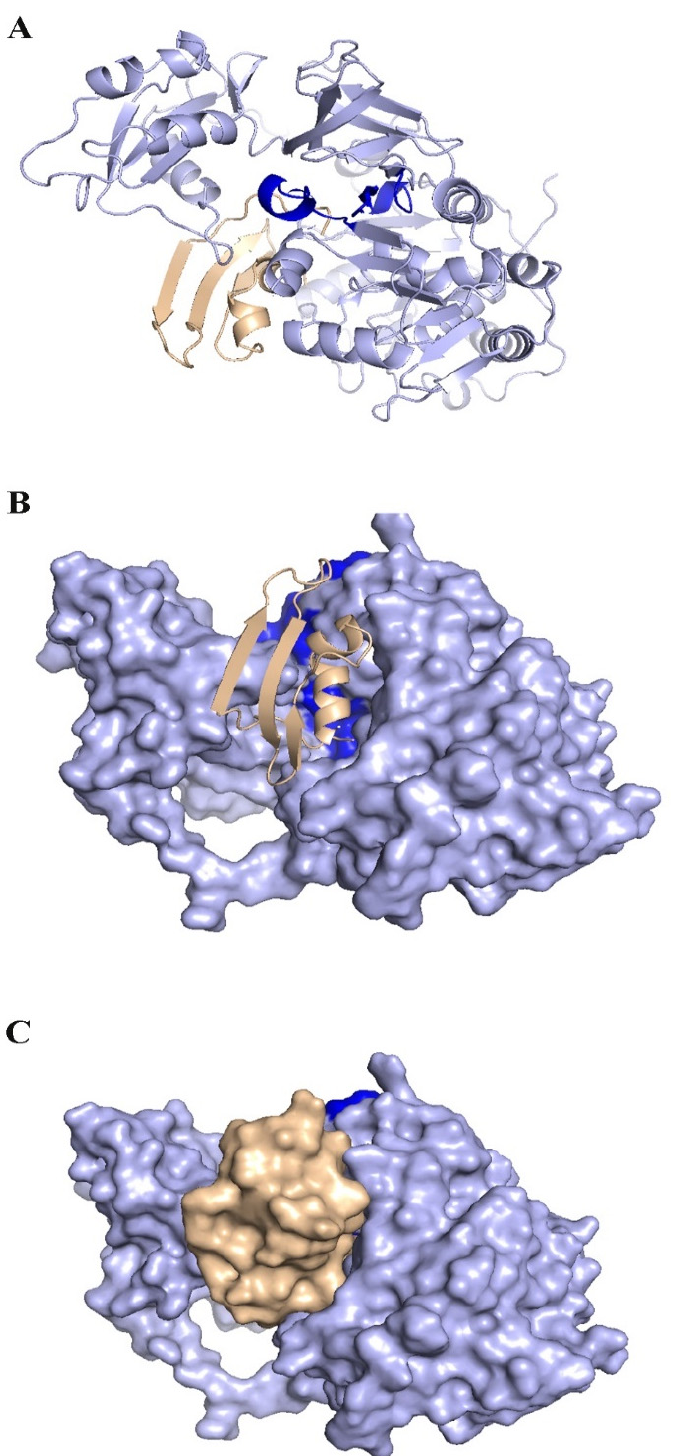
Figure 12. KAE01 EntP complexed with matrix protein. KAE01 EntP model (wheat color) with AB method complexed with matrix protein (light-blue color). Highly conserved residues Gly307, Gly302, Ala278, Gly279, His308, and Tyr211 in N-terminal domain are highlighted in dark blue. ( A ) Shows Ribbon representations ( B ) KAE01 Cavity occupied surface of protein ( C ) Both are represented in surfaces The KAE01 EntA bacteriocin binds to the matrix protein of P. aeruginosa in three clus- ters with 46 members from 1000 bootstraps in the best binding mode with a binding en- ergy of − 12.4 Kcal/mol and an inhibition constant of 0.8 nM (Table 5). KAE01 EntA local- izes near the conserved region of the N-terminal domain of the matrix protein of P. aeru- ginosa (G166, S167, and T169 loop in the N-terminal domain and F208 F209, G210, G279, and Ser280 residues in the N-terminal domain) (Figure 13). Since the mode of binding of